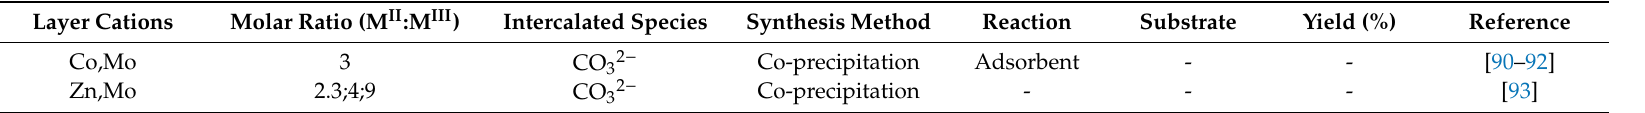
Table 7. Summary of M Mo-LDH ( M